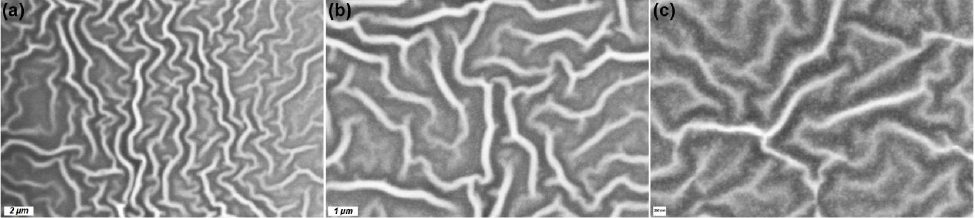
Figure 1. SEM images of the PTB7-Th:PC 70 BM:PC 60 BM blend film with SANR structures under different scales: ( a ) 2 µ m, ( b ) 1 µ m, and ( c ) 200 nm.